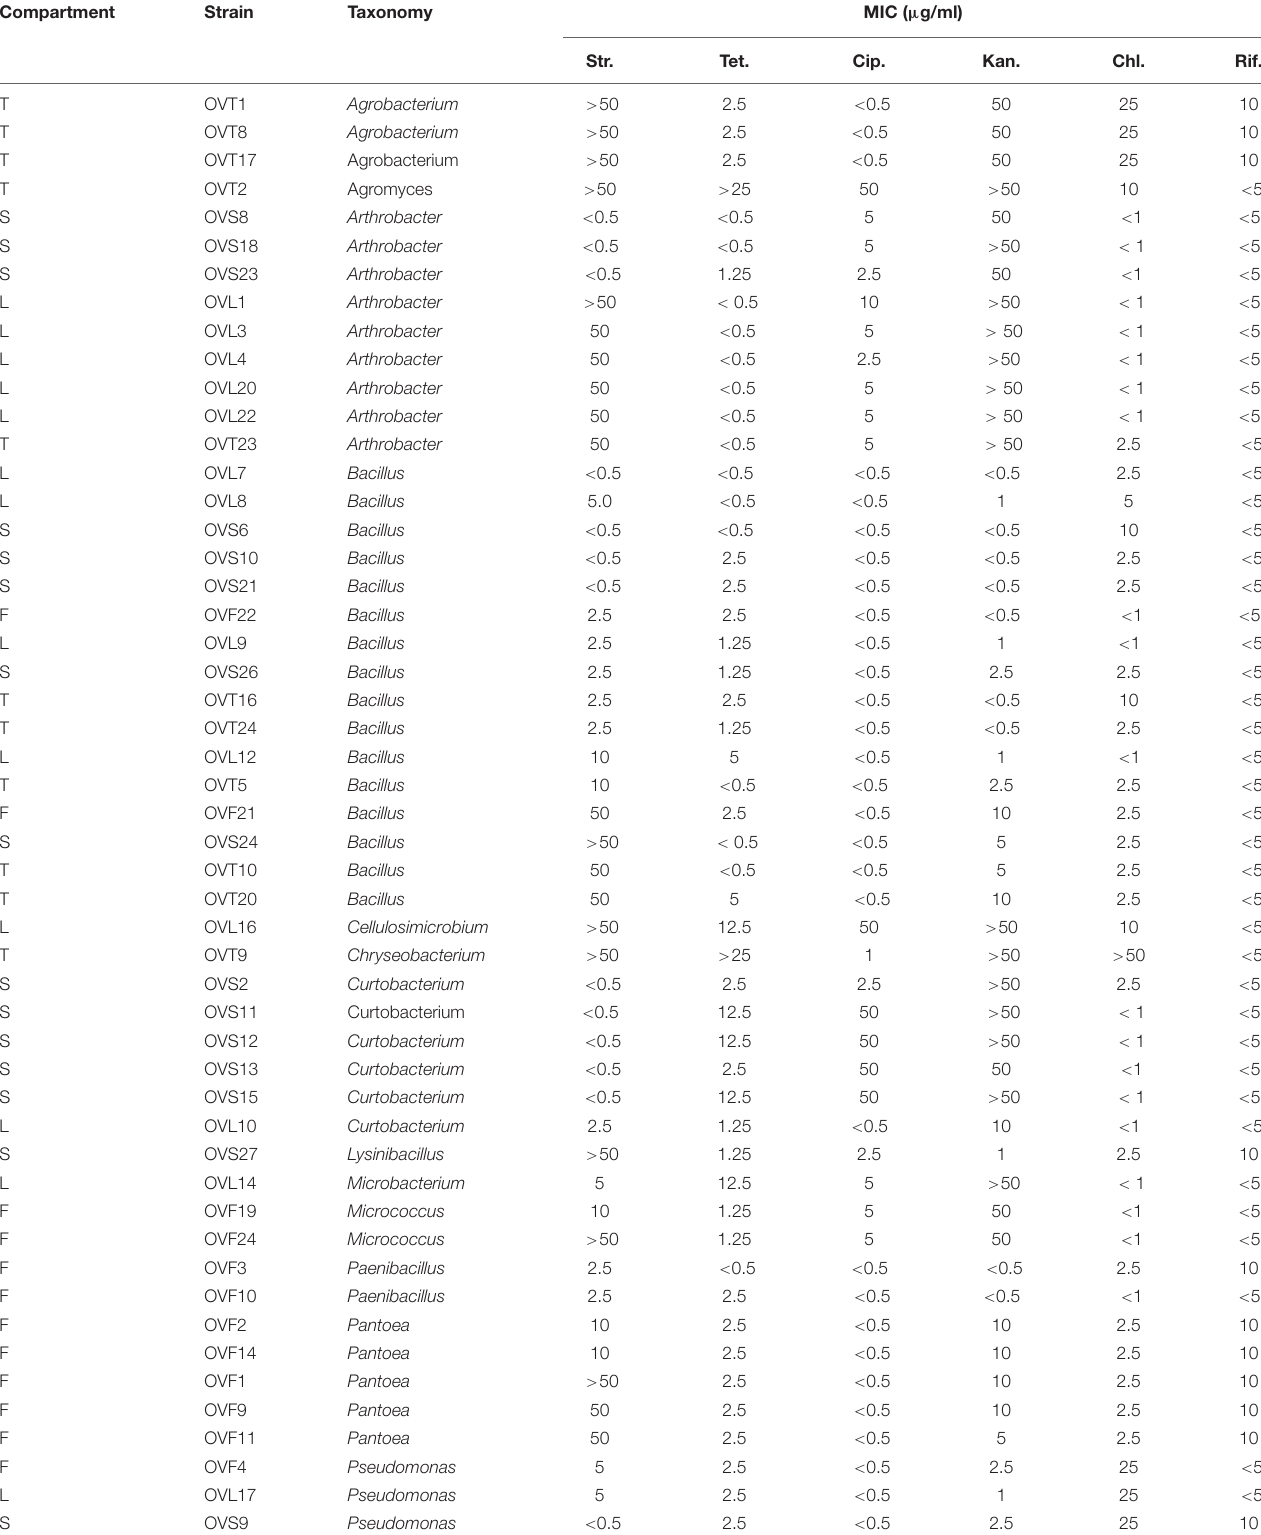
TABLE 5 | Antibiotic resistance assay of O. vulgare associated bacteria. Compartment Strain